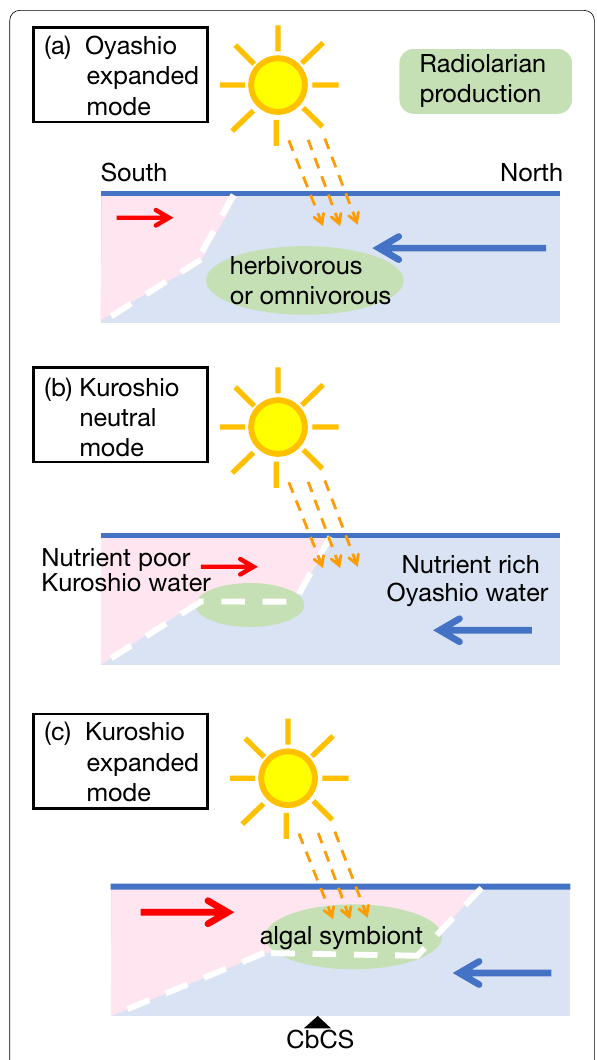
Fig. 5 Schematics of oceanographic conditions indicating a Oyashio expanded mode, likely present in late MIS 20 and characterized by high radiolarian productivity, and b neutral mode in MIS 19, when the Kuroshio–Oyashio layered structure was contracted, and c same conditions, but with Kuroshio extended mode when the layer structure was